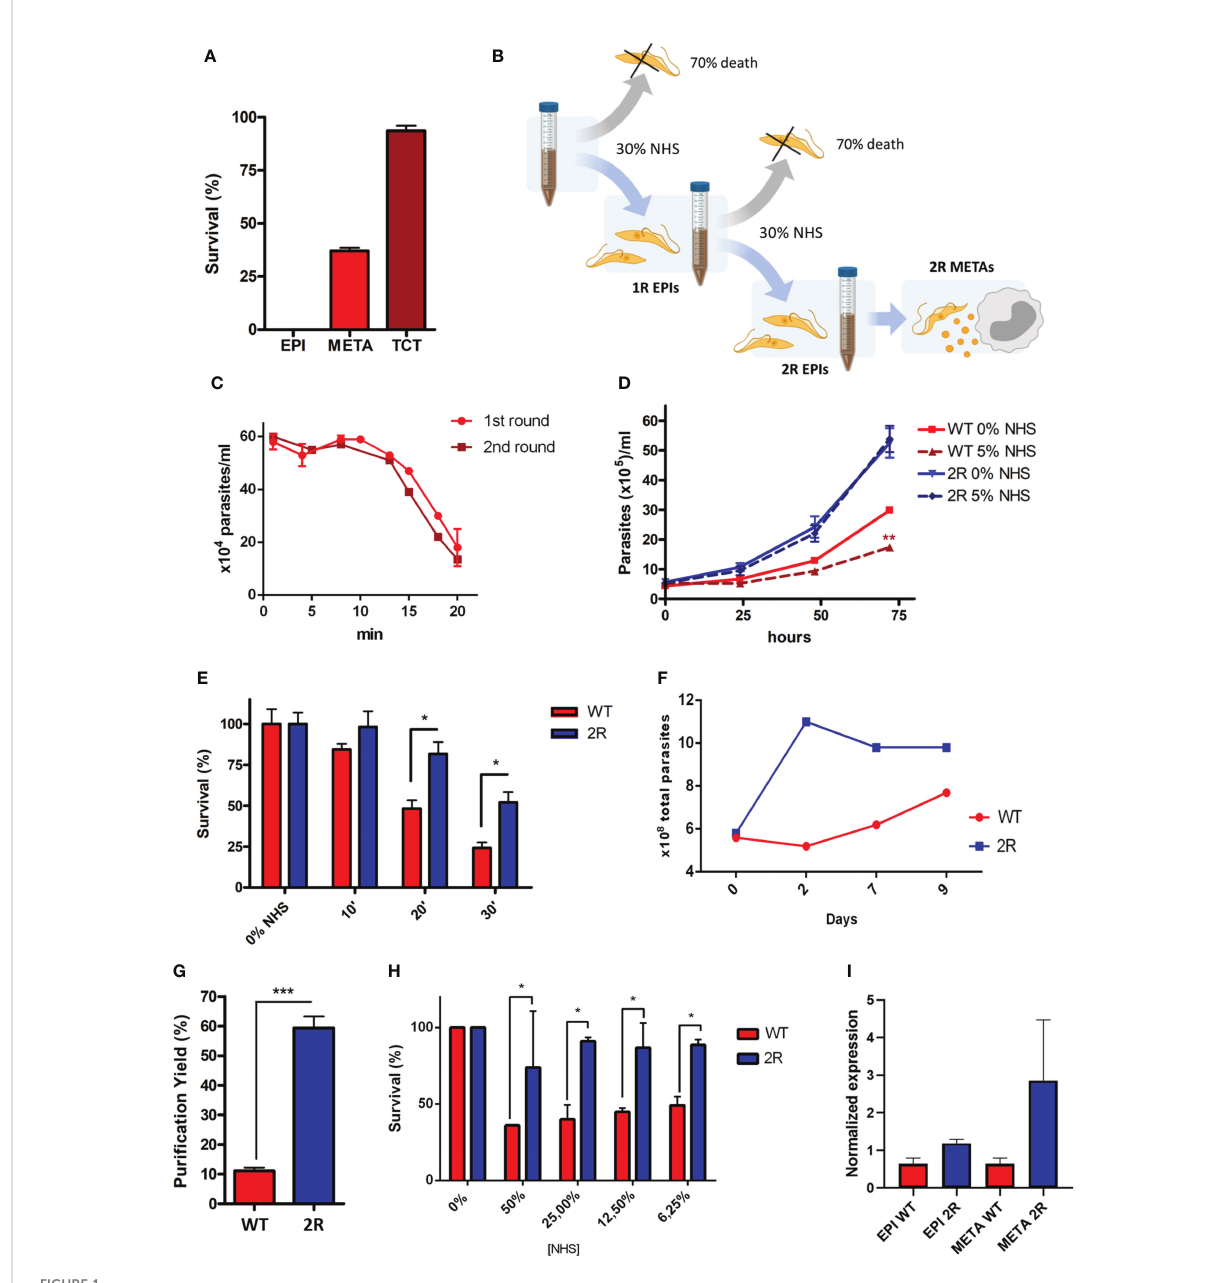
FIGURE 1 (A) Resistance to complement-mediated lysis of different stages of Trypanosoma cruzi to 50% normal human serum (NHS) exposition for 30 min. (B) Schematic representation of the selection protocol of epimastigote populations (1R and 2R) resistant to complement lysis. The selection protocol is based on a short exposition to high NHS concentrations (30% NHS). (C) Parasite survival under 30% NHS exposure during the fi rst and second rounds of selection. (D) EPI growth curve in the LIT medium and with the addition of 5% NHS. (E) EPI complement- mediated lysis kinetics at 6.25% NHS. (F) Viability of parasites (parasites with normal morphology and movement) after metacyclogenesis induction by nutritional starvation (approximately 2.5% FBS fi nal concentration). (G) Yield of metacyclic trypomastigote (META) puri fi cation by ion exchange chromatography. (H) Comparison of complement-mediated lysis resistance at different NHS concentrations for 30 min between META wild type (WT) and 2R. (I) Expression of CRIT by epimastigotes and METAs of WT and 2R evaluated by quantitative real-time PCR. * P<0.05. ***